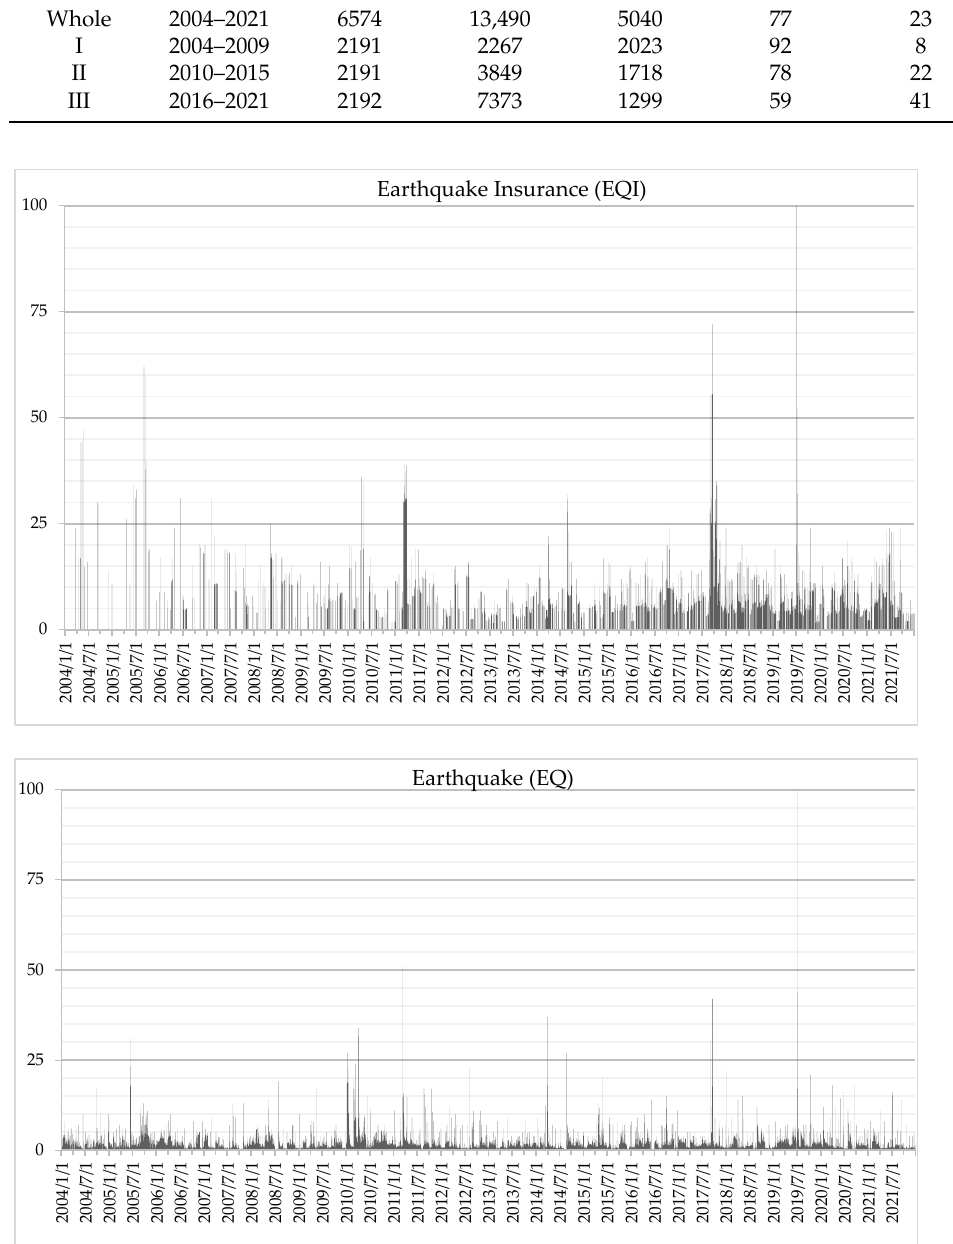
Figure 4. GT daily search interest (2004–2021) for earthquake insurance ( upper panel ) and earthquake ( lower panel ).